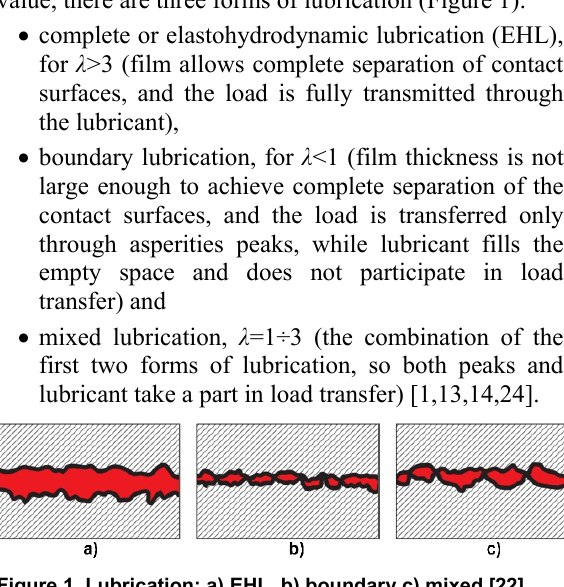
Figure 1. Lubrication: a) EHL, b) boundary c) mixed